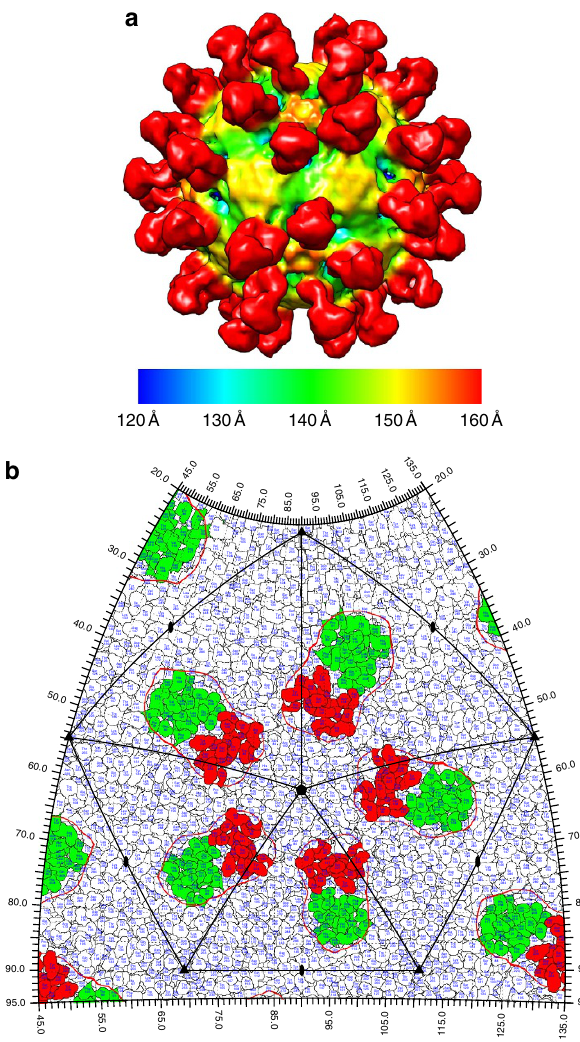
Figure 4 | HPeV3–Fab structure. ( a ) Radially coloured isosurface representation of HPeV3–Fab AT12-015 complex at 15Å resolution shown at 1.5 s above the mean threshold. The Fab molecules (red) bind around the canyon region. ( b ) HPeV3 roadmap. The Fab footprint (red contour) is mapped to VP3 (green) and VP1